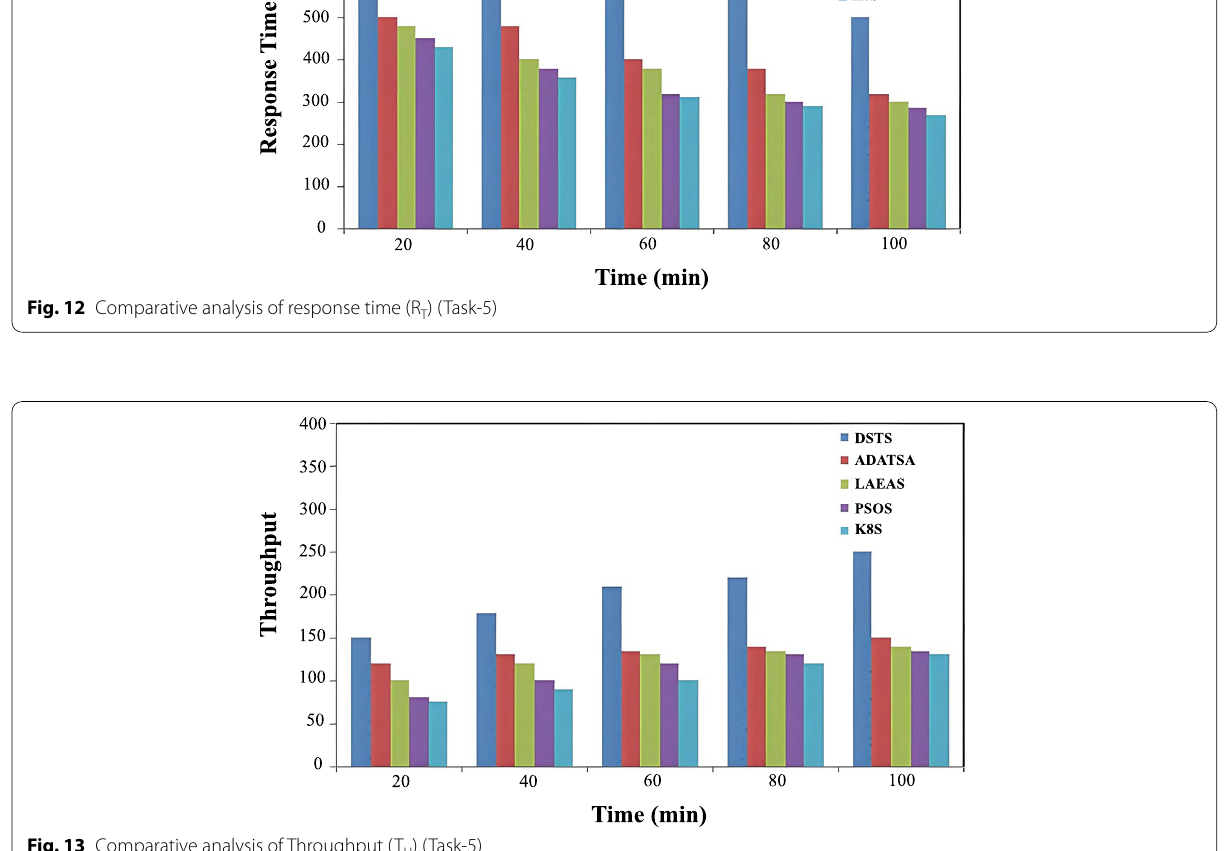
Fig. 13 Comparative analysis of Throughput (T H ) (Task-5)